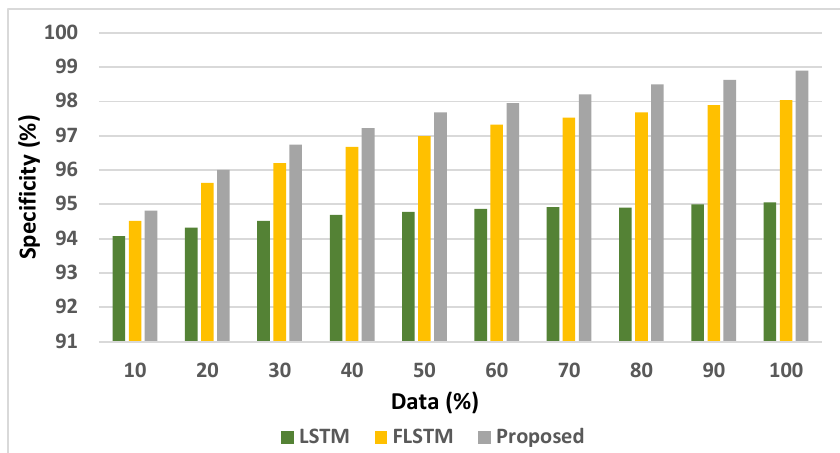
Figure 8. Specificity analysis.